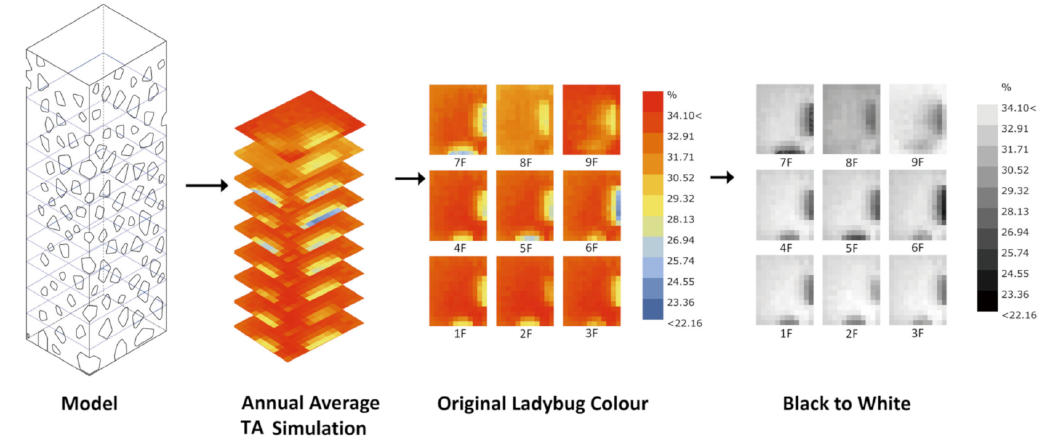
Figure 11. Thermal comfort simulation showing thermal autonomy